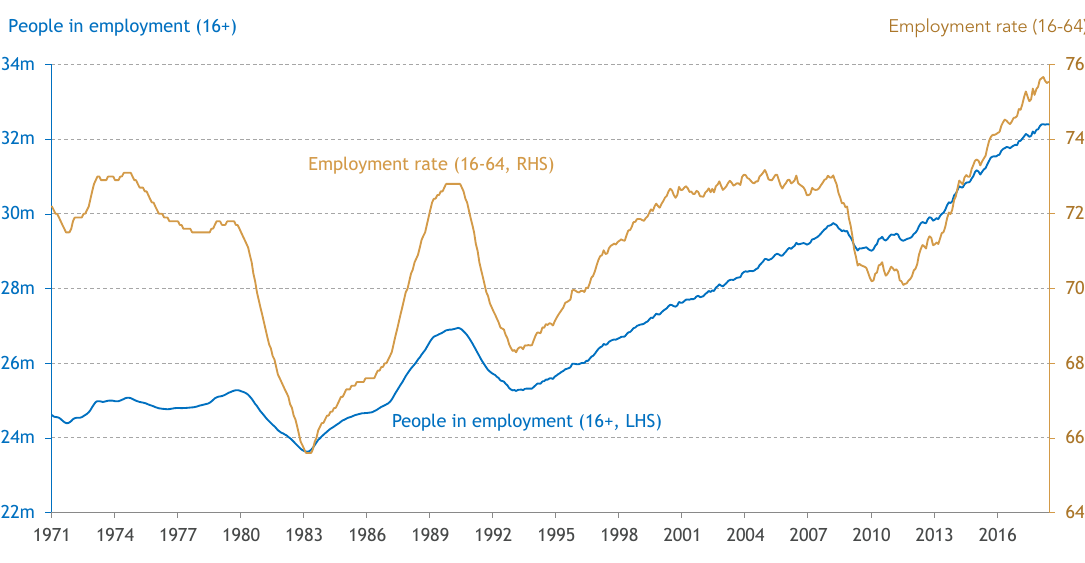
Figure 1: Employment levels and rates are higher than at any time on record